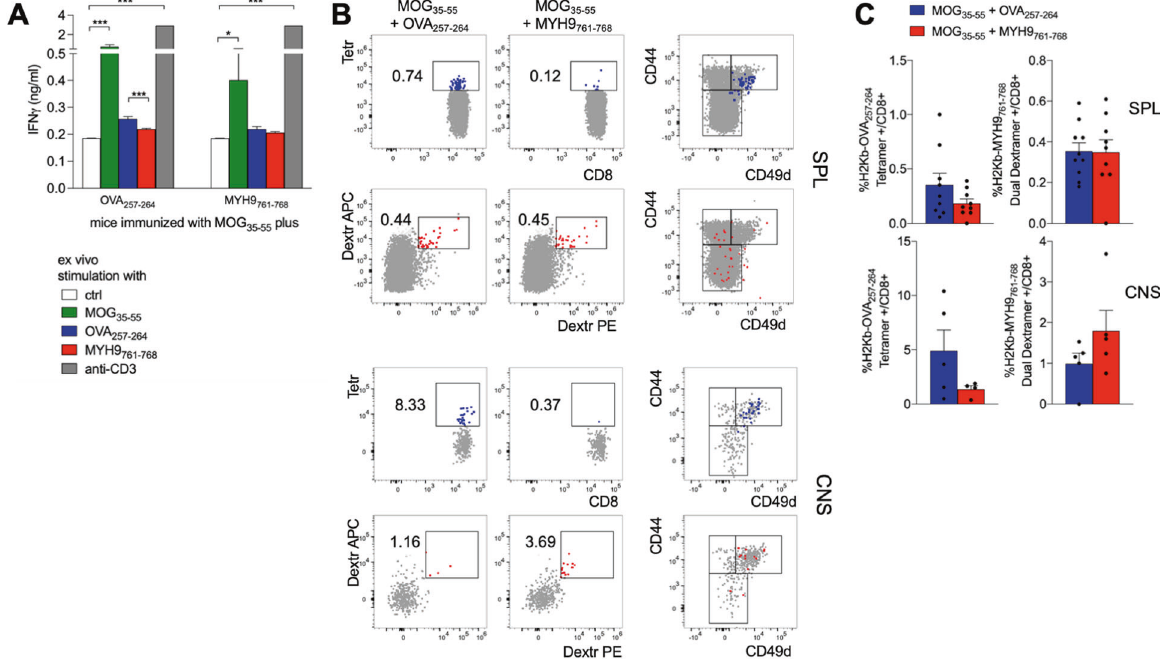
Fig. 7 MYH9 761-768 immunization enhances antigen-speci fi c response in the CNS of mice with EAE. C57BL/6 mice, immunized with 100 µg MOG 35-55, admixed with OVA 257-264 ( n = 10) or with MYH9 761-768 ( n = 9), were sacri fi ced at day 29. A Splenocytes were challenged ex vivo for 48 hr with the indicated stimuli and IFN- γ was measured in the supernatants through ELISA. Bars represent means ± SEM. * P < 0.05, *** P < 0.005, by Mann – Whitney test. B Representative stainings of OVA 257-264 -speci fi c (blue) or MYH9 761-768 -speci fi c (red) cells in CD8 + T cells from SPL or CNS of mice immunized with MOG 35-55 plus the indicated peptides. Right plots show CD44/CD49d expression in gated antigen-speci fi c or total (gray) cells. C Cumulative analysis of the percentage of OVA 257-264 -speci fi c (left plots) or MYH9 761-768 -speci fi c (right plots) cells in CD8 + T cells from SPL or CNS of mice immunized with MOG 35-55 plus OVA 257-264 (blue) or MYH9 761-768 (red). The data are from a single experiment representative of two independent experiments. Bars represent means ±